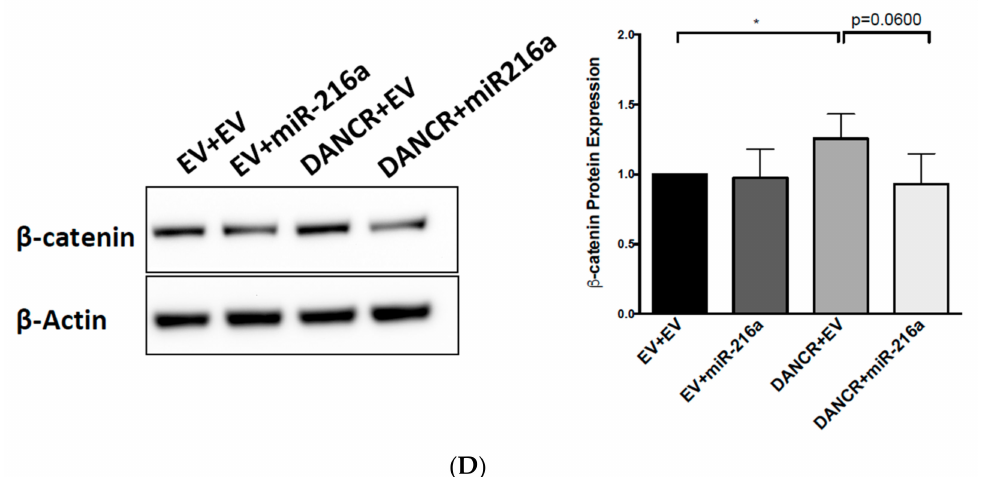
Figure 6. DANCR promotes Wnt / β -catenin signaling through miR-216a inhibition. ( A ) qRT-PCR measuring fold change of DANCR expression in A549 cells transfected with pBABE-DANCR compared tovectorcontrol( n = 3; t test, ** p < 0.001); ( B )foldchangeof β -cateninproteinexpressioninA549DANCR overexpressing cells ( n = 3, t test, ** p < 0.001); ( C ) (left) qRT-PCR measuring fold change of DANCR expression in A549 cells doubly transfected with vector + vector (EV + EV), vector + pBABE-miR-216a (EV + miR-216a), vector + pBABE-DANCR (EV + DANCR), or pBABE-DANCR + pBABE-miR-216a (DANCR + miR-216a); (right) qRT-PCR measuring fold change of miR-216a expression ( n = 4, t